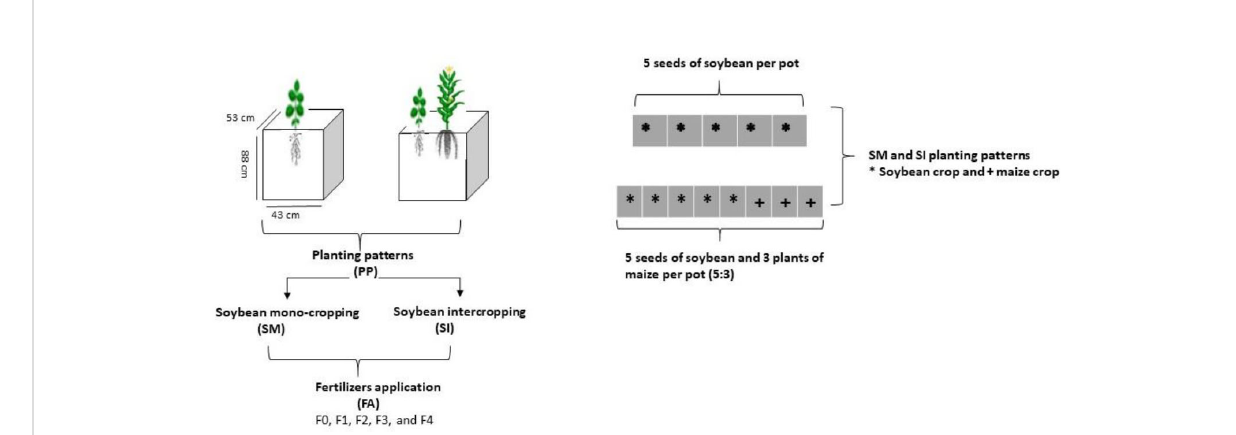
FIGURE 1 Schematic diagram of the experiment. F0 ; without fertilizer application, F1 ; nitrogen fertilizer application, F2 ; nitrogen fertilizer with foliar application of iron, F3 ; nitrogen fertilizer with foliar application of molybdenum, F4 ; nitrogen fertilizer with foliar application of iron and